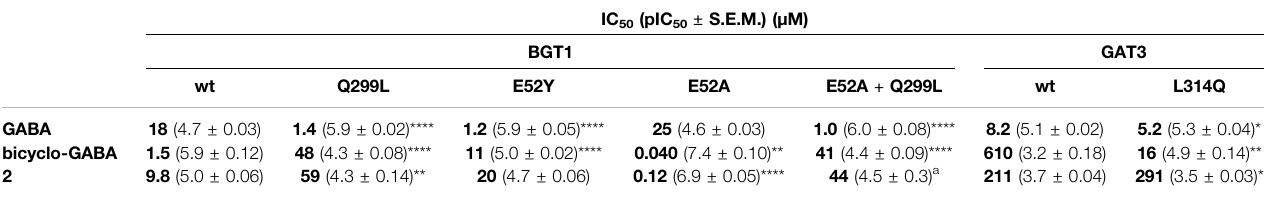
TABLE 2 | Inhibitory activities of GABA, bicyclo-GABA and 2 tested in the [ 3 H]GABA uptake assay at BGT1, GAT3 and selected mutants transiently expressed in tsA201 cells. Data represent at least three independent experiments in triplicates unless otherwise indicated. pIC 50 values at the mutants were compared to wt by one-way ANOVA followed by Dunnett ’ s multiple comparison test (BGT1) or by multiple unpaired t-tests corrected for multiple comparisons using the Holm- Š ídák method (GAT3), signi fi cance levels * p < 0.05, ** p < 0.01, *** p < 0.001, **** p <